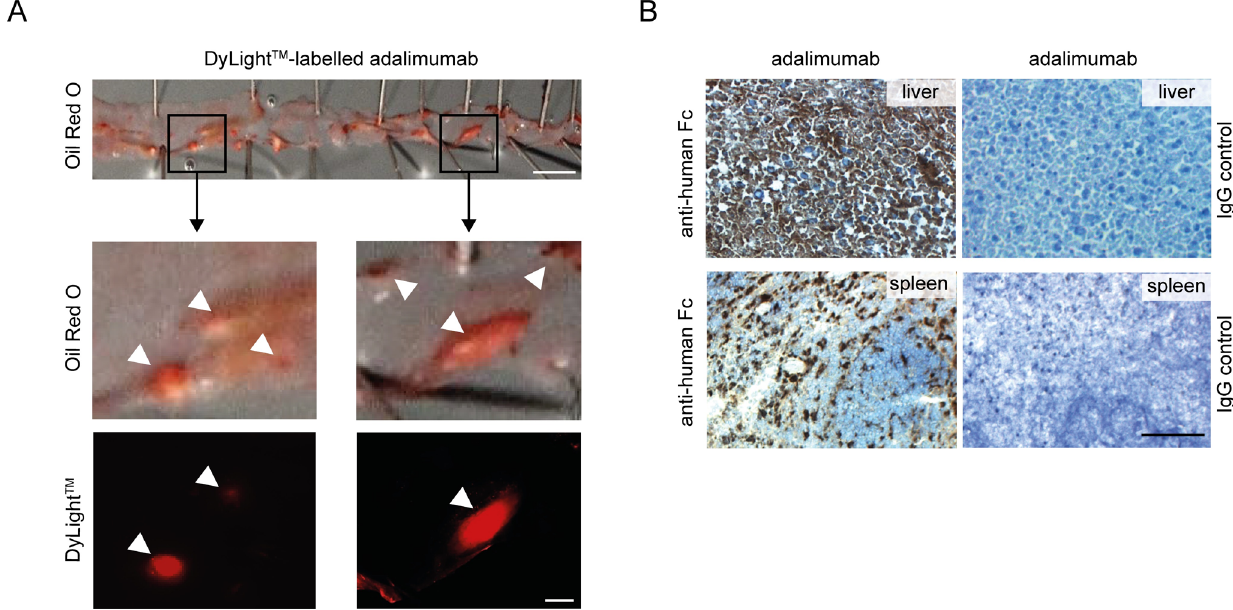
Fig 7. Deposition of adalimumab in aorta, liver and spleen. (A) Aortas of hypercholesterolemic Ldlr ‒ / ‒ mice were washed and prepared en face 12 hours after injection of DyLight-549-labelled adalimumab (8.0 mg/kg, i.p.). Fluorescence images (bottom panels) from the aorta were captured before Oil Red O staining (top panels). Lesion area and vascular fluorescence accumulation are indicated by white arrows. Scale bars = 2.5 mm (top panel) and 200 μ m (bottom panels). One representative experiment is shown. (B) Immunohistochemical analysis of adalimumab deposition with anti-human Fc or IgG control antibodies in liver and spleen of hypercholesterolemic Ldlr ‒ / ‒ mice 12 hours after injection of adalimumab (8.0 mg/kg, i.p.). Scale bar = 100 μ m. Representative pictures are